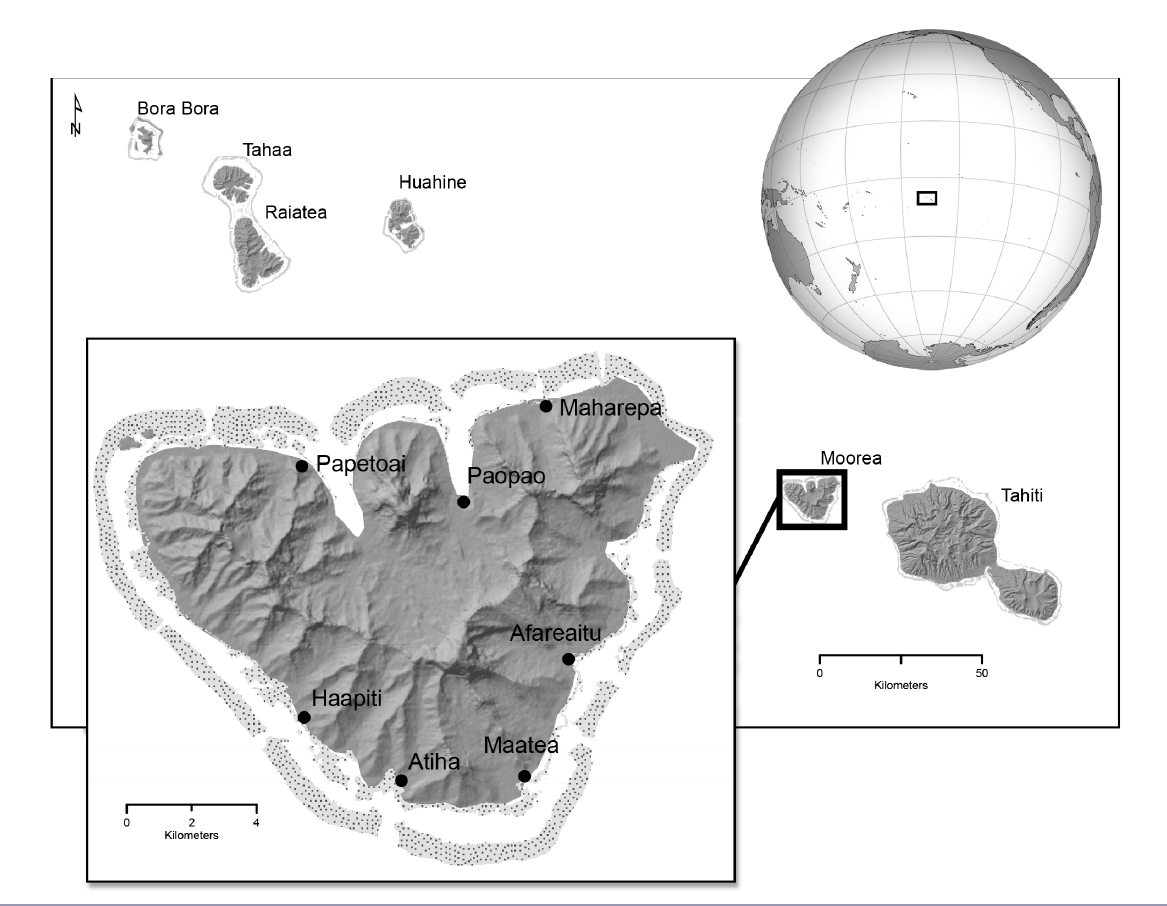
Fig. 1 . The location of the Society Islands and Moorea. The coral-reef lagoon ecosystem that surrounds the island is highlighted in gray and